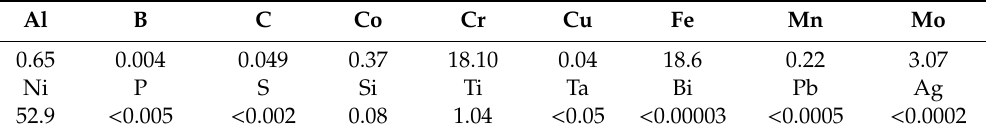
Table 1. Chemical composition of the Inco718 material (wt.%).